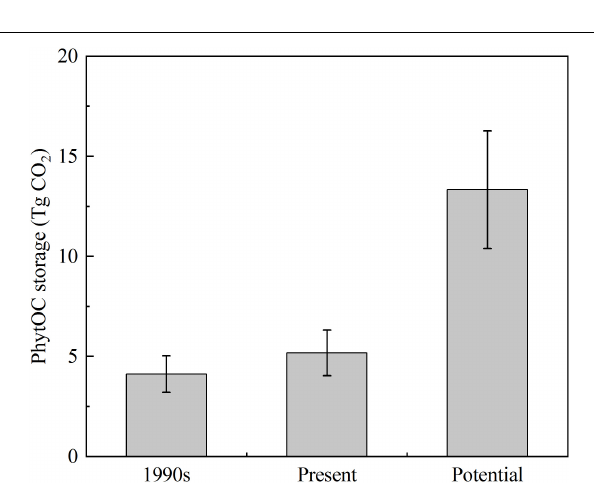
FIGURE 4 | The PhytOC storages of litter layer in the world’s bamboo ecosystem in 1990s, present, and